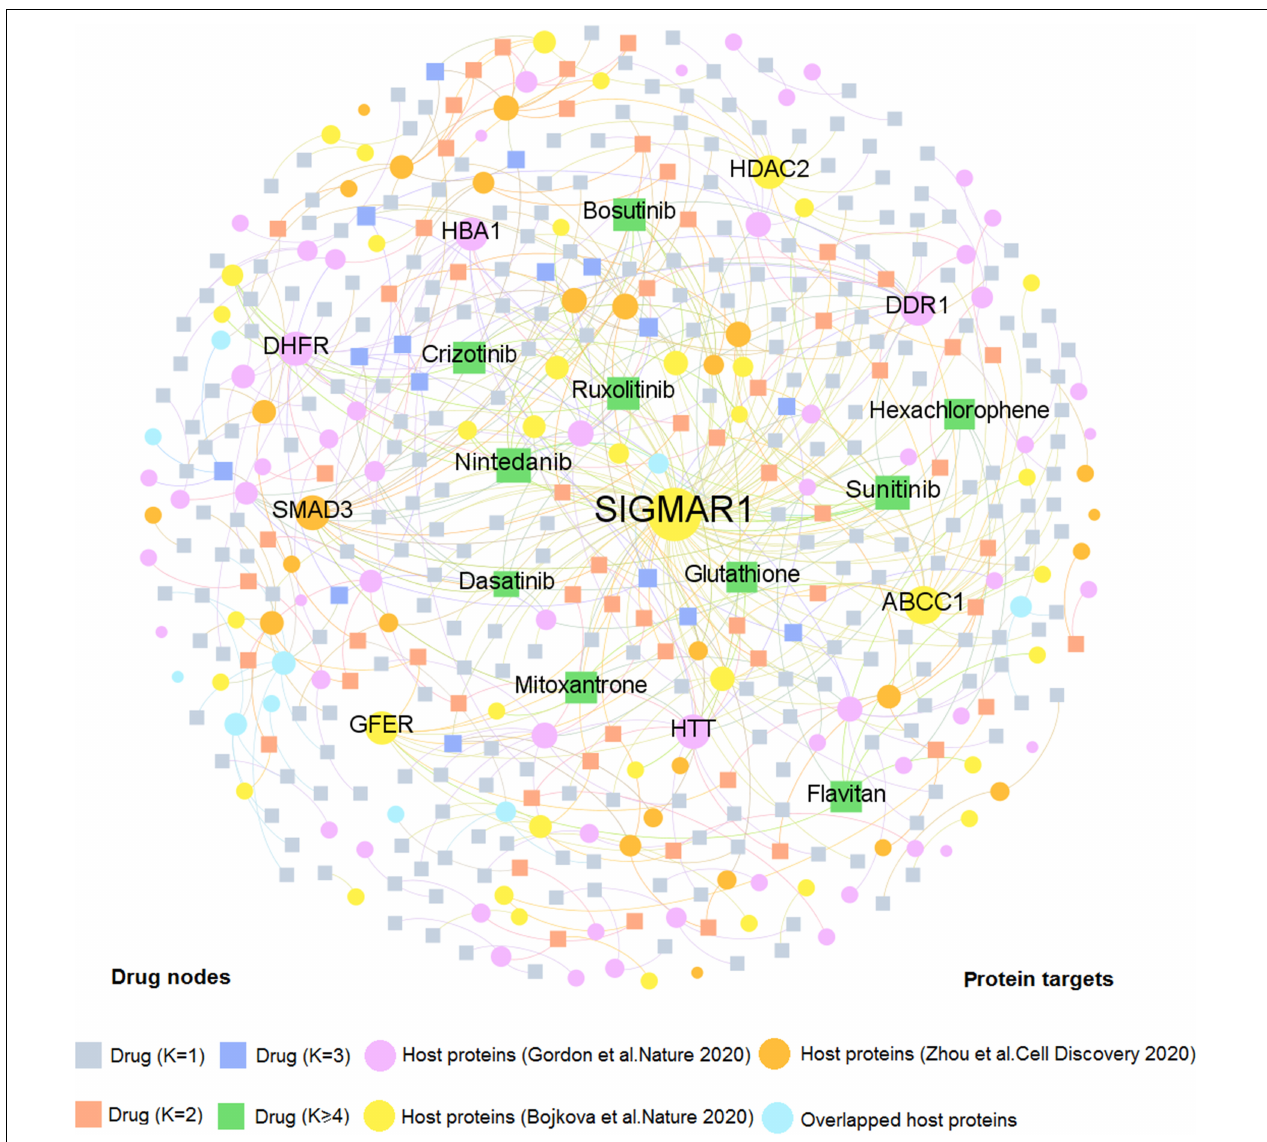
FIGURE 3 | A bipartite drug–target network for approved drugs from the Drugbank database. This network contains 490 DTIs interacting 331 drugs with 137 human host proteins. The dot stands for the host protein target while the square node represents the drug. The label font size and node size are proportional to degree (connectivity). Only labels of the top 10 drugs and targets with the highest degree are